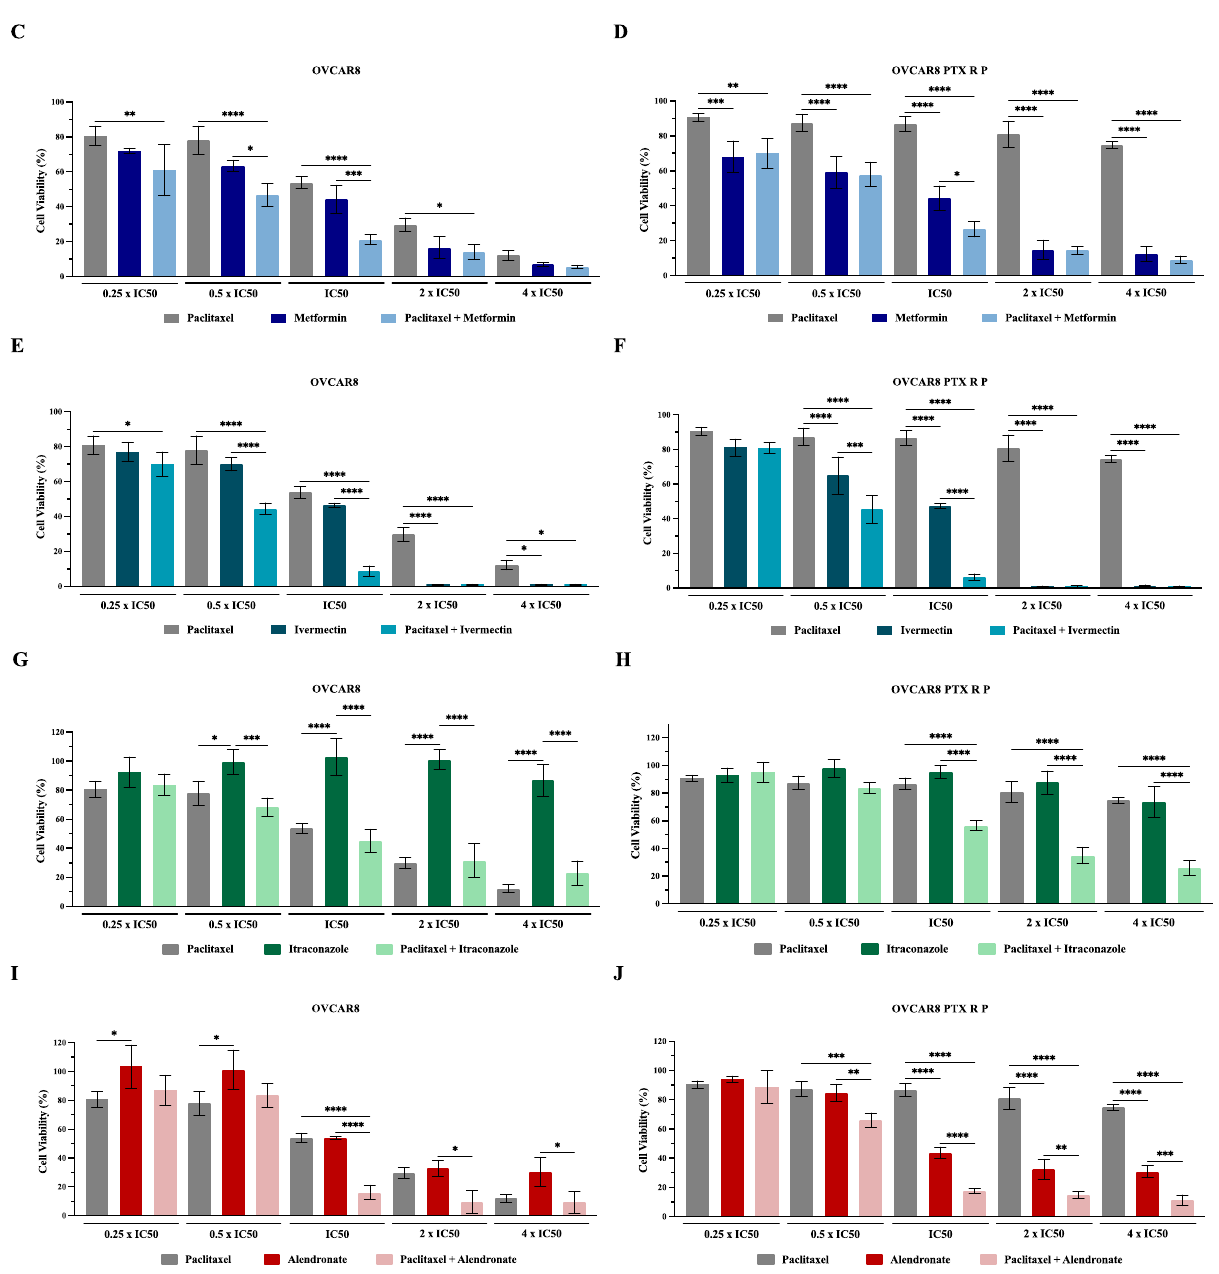
Figure 2. Repurposed drugs increase the efficacy of Paclitaxel in reducing cellular viability of chemoresistant high ‐ grade serous carcinoma cells. ( A – J ) Bar charts showing cell viability of OVCAR8 and OVCAR8 PTX R P cells obtained by Presto Blue assay after exposure to a fixed-dose ratio that corre- sponds to 0.25, 0.5, 1, 2 and 4 times the individual IC 50 values of each drug, e.g., Paclitaxel combined with ( A , B ) Pitavastatin, ( C , D ) Metformin, ( E , F ) Ivermectin, ( G , H ) Itraconazole and ( I , J ) Alendronate for 48 h. The combined treatment was co-administered at the same time. All assays were performed in triplicate in at least three independent experiments. Data are expressed as mean ± standard deviation and are plotted using GraphPad Prism Software Inc. v6. Statistical analysis was performed using ordinary one-way ANOVA followed by Šıd á k’s multiple comparison test ( A – J ), and values of * < 0.05; ** < 0.001; *** <0.005; **** < 0.0001 were considered statistically